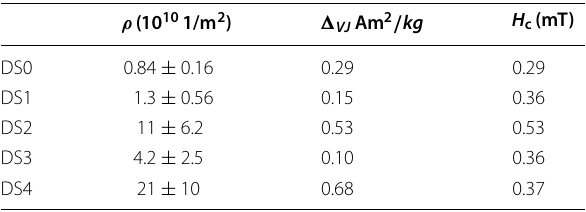
Table 2 Calculated (cid:31) VJ values from RTSIRM measurements for each sample, tabulated with dislocation density and coercivity (also in Table 1). (cid:31) VJ was calculated by subtracting the minimum magnetization at T v from the maximum magnetization approximately 10 K below T v , as described in Muxworthy et al. (2003)